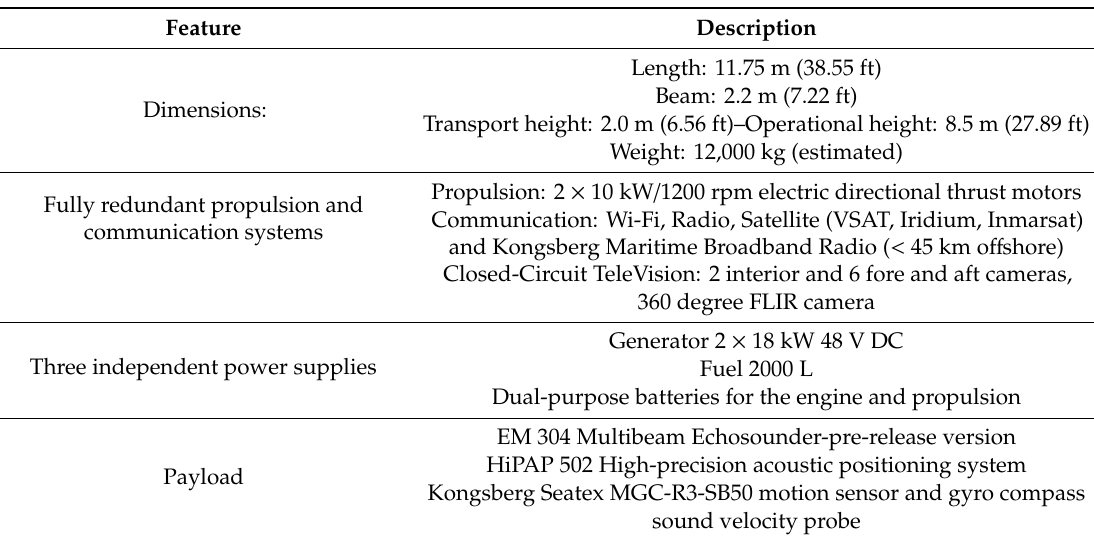
Table 5. Specifications of unmanned surface vessel (USV) SEA-KIT ‘Maxlimer’